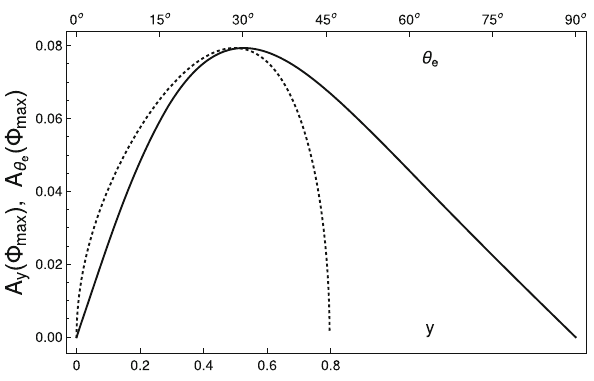
Fig. 4 Standard V − A interaction, E ν = 1 MeV .Plotoftheazimuthal asymmetry functions: A y (Φ = π/ 2 ) as a function y (dotted line) and (Φ = π/ 2 ) as a function of θ A θ e (solid line) e